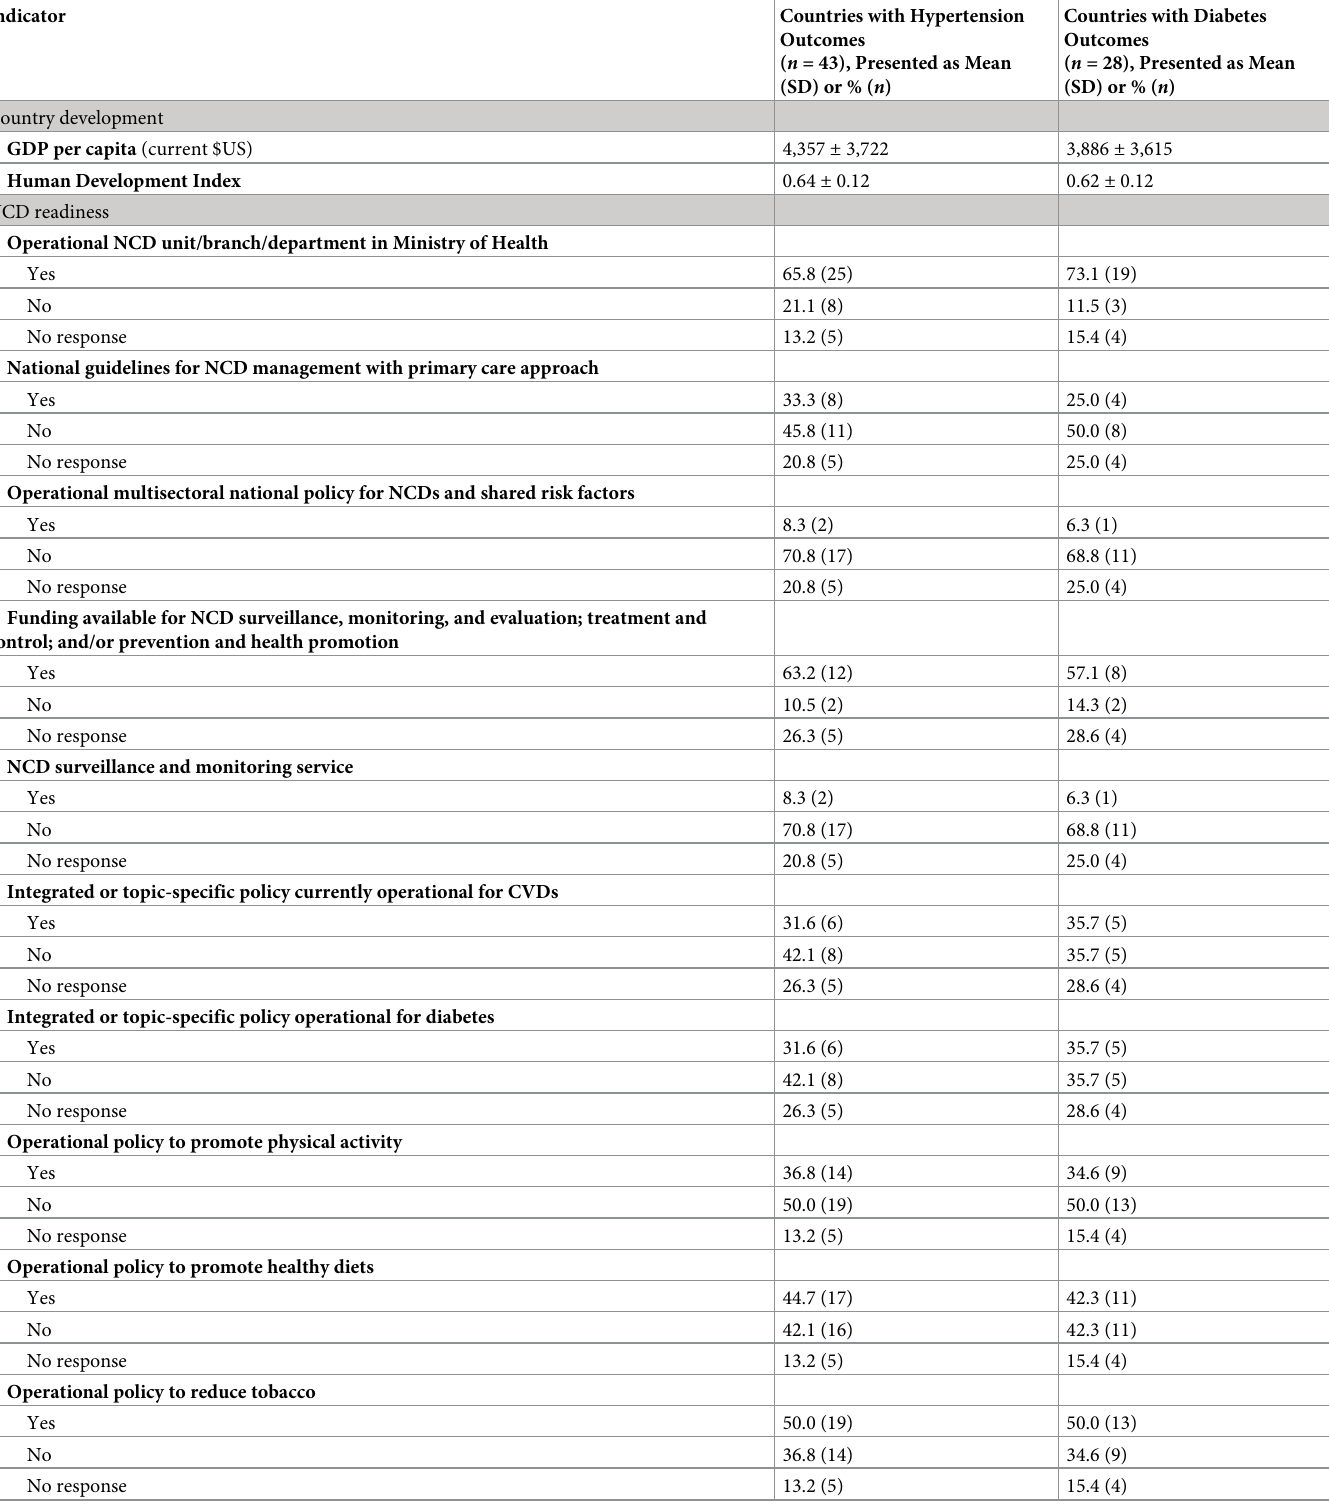
Table 2. Summary of country-level indicators assessed in this analysis, presented for countries for which hypertension or diabetes outcomes were available to study. Indicator Countries with Hypertension